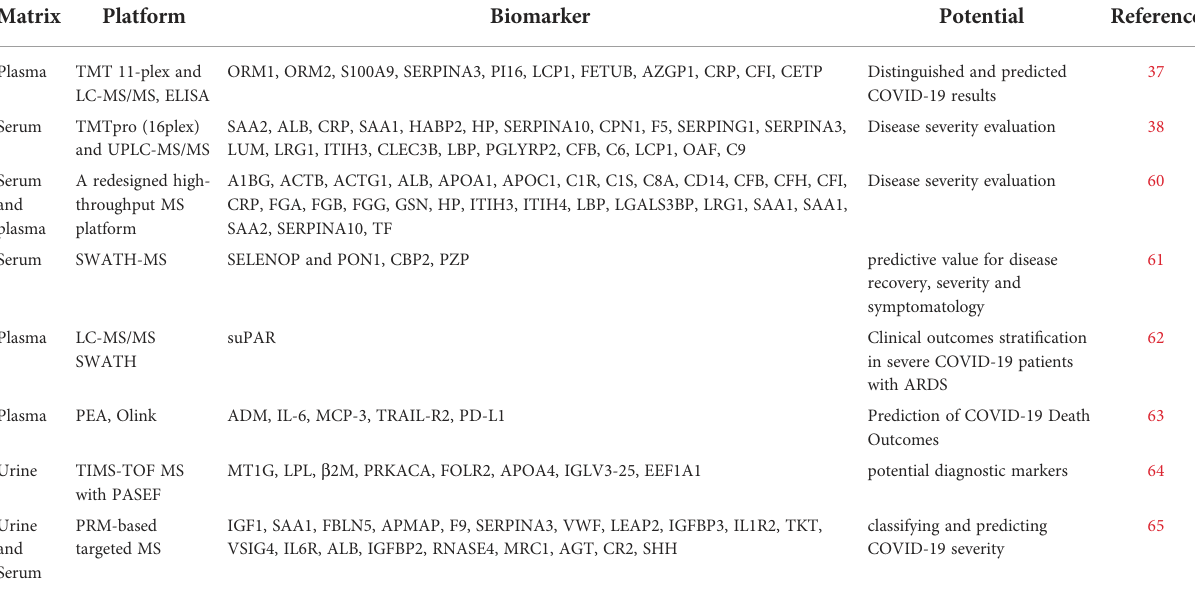
TABLE 1 Potential body fl uid Protein Biomarkers of COVID-19.